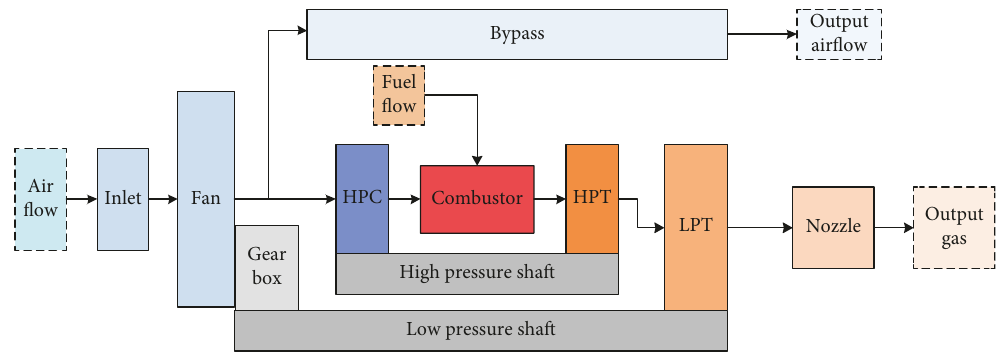
Figure 1: Schematic con fi guration of DGEN380 aero